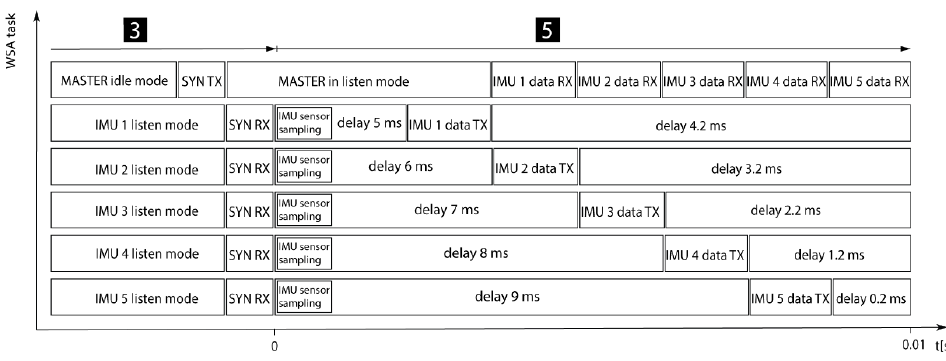
Figure 4. WSA tasks sequences in a single 10-ms sample